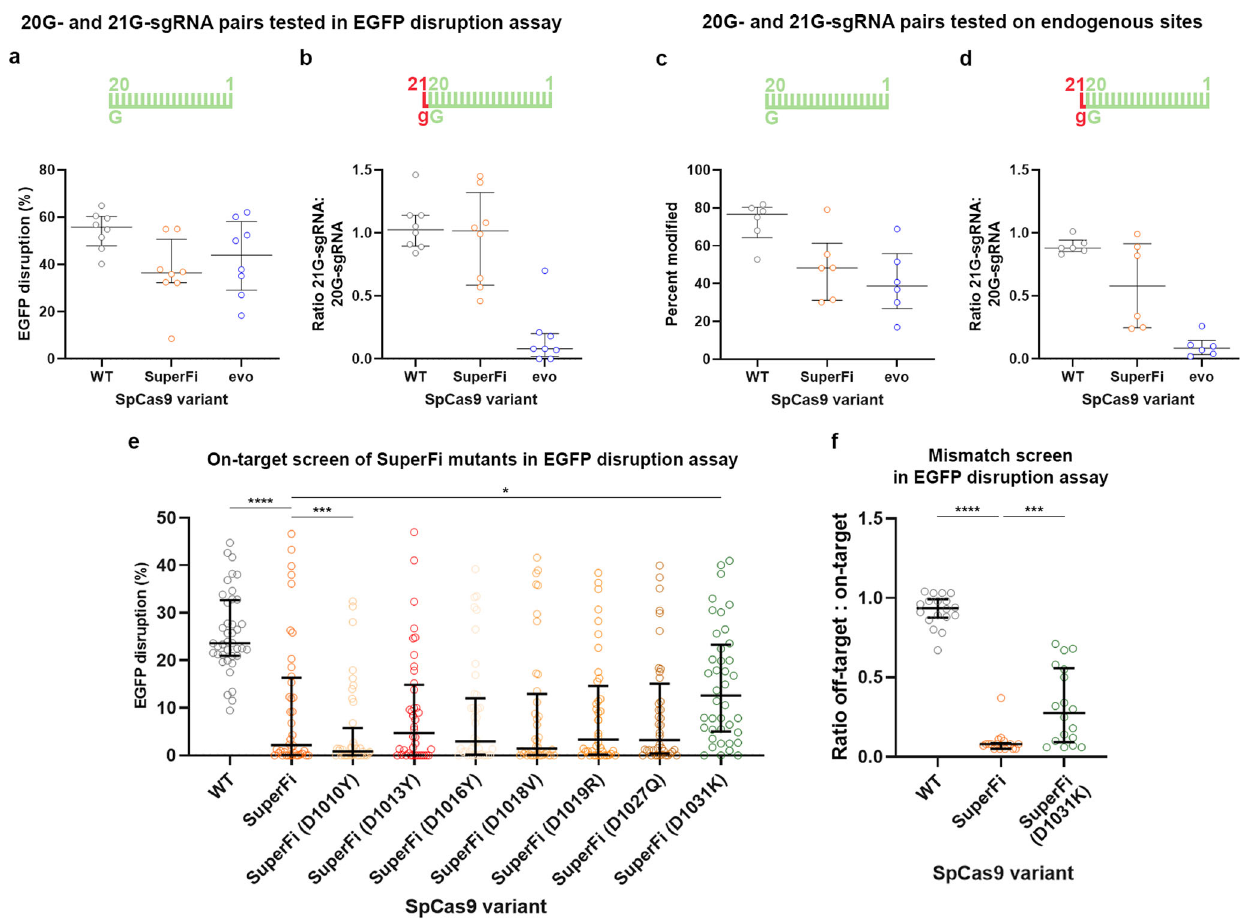
Fig. 2 | Characterization of SuperFi and its variants in mammalian cells. a – d ( a , b ) EGFP disruption activity on 8 target sites and c , d indels measured on 6 endogenous sites with a , c 20G-sgRNAs and the same sites targeted with b , d 21G- sgRNAs, normalized to their 20G-sgRNA counterparts, presented on a scatter dot plot. Data are related to Supplementary Fig. 5b, c. e On-target activity of various SpCas9variantsasmeasuredinEGFP disruptionassayon40targetsitespresented on a scatter dot plot. Data are related to Supplementary Fig. 6. f Normalized EGFP disruption activity of SpCas9 nucleases with perfectly matching ( n =18) and par- tiallymismatching( n =162)20G-sgRNAs.Dotsareshownforeachvariantwitheach